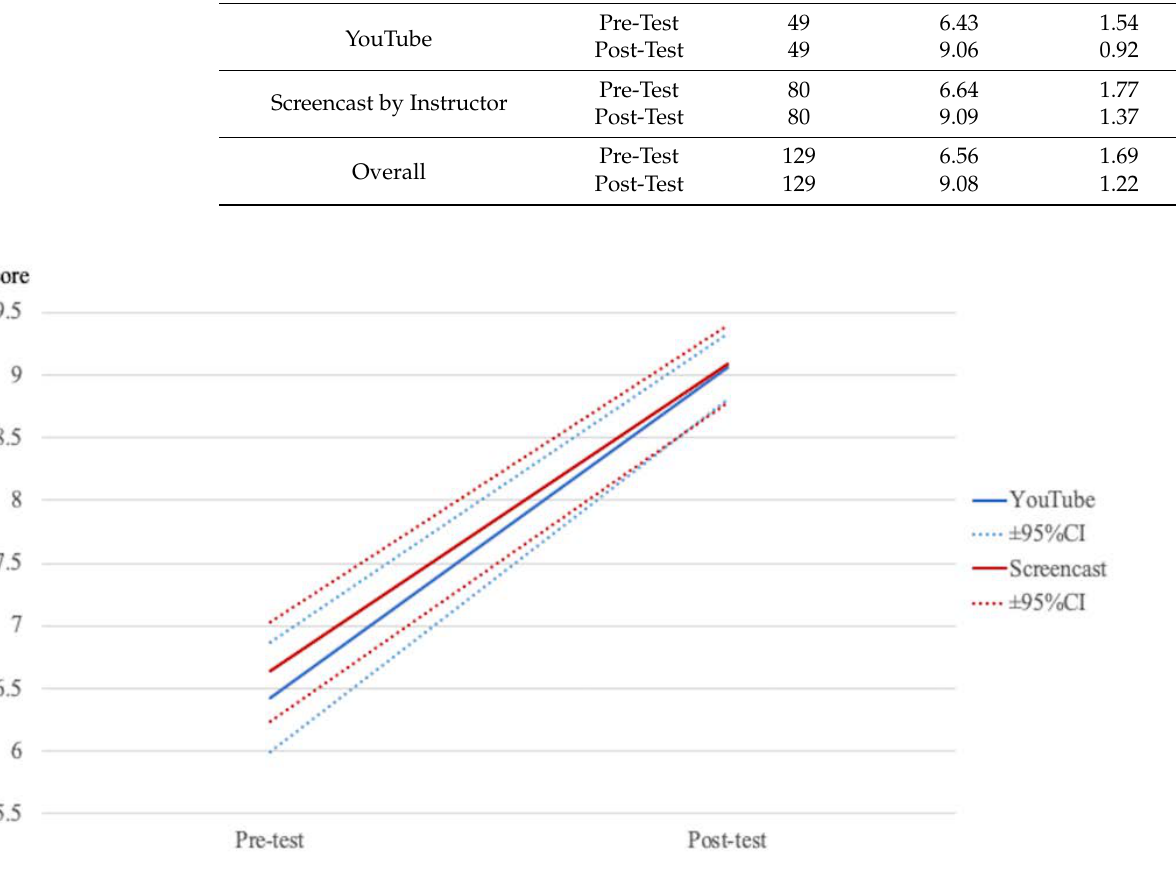
Figure 2. Results of the analysis of covariance. Table 1. Descriptive statistics of the pre and post-tests in both groups.